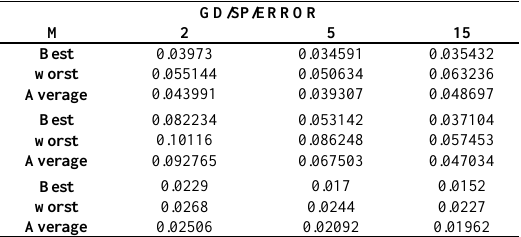
Table 11. GD/SP/ERROR analysis on the first proposed